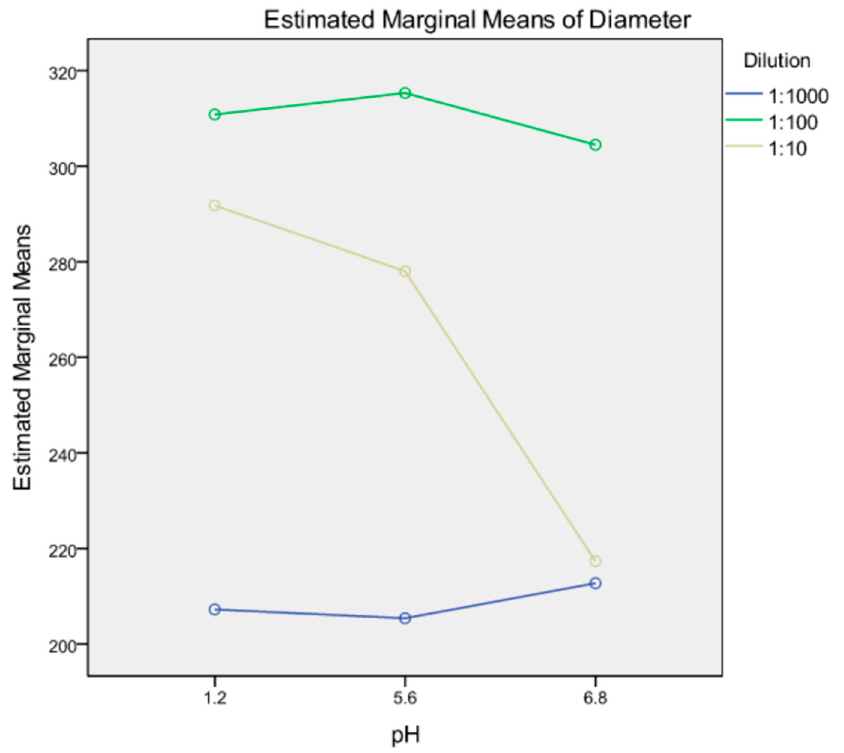
Figure 4. Interaction plots for the effects of pH and dilution factor on the hydrodynamic diameter of sonicated emulsions.